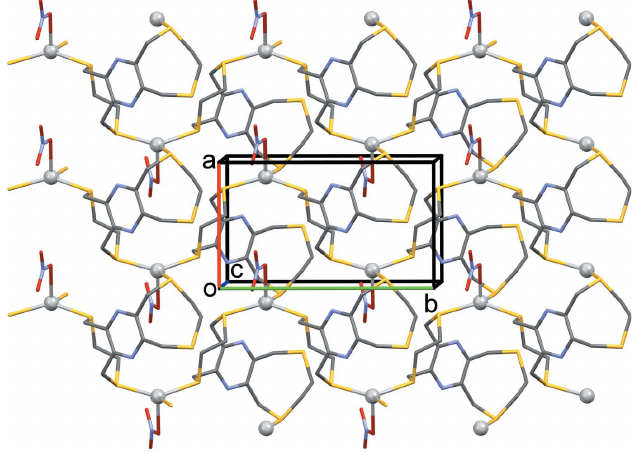
Figure 9 A view along the c axis of the crystal packing of complex II , illustrating the formation of the metal–organic network. The silver atoms are shown as grey balls. For clarity, the H atoms have been omitted.